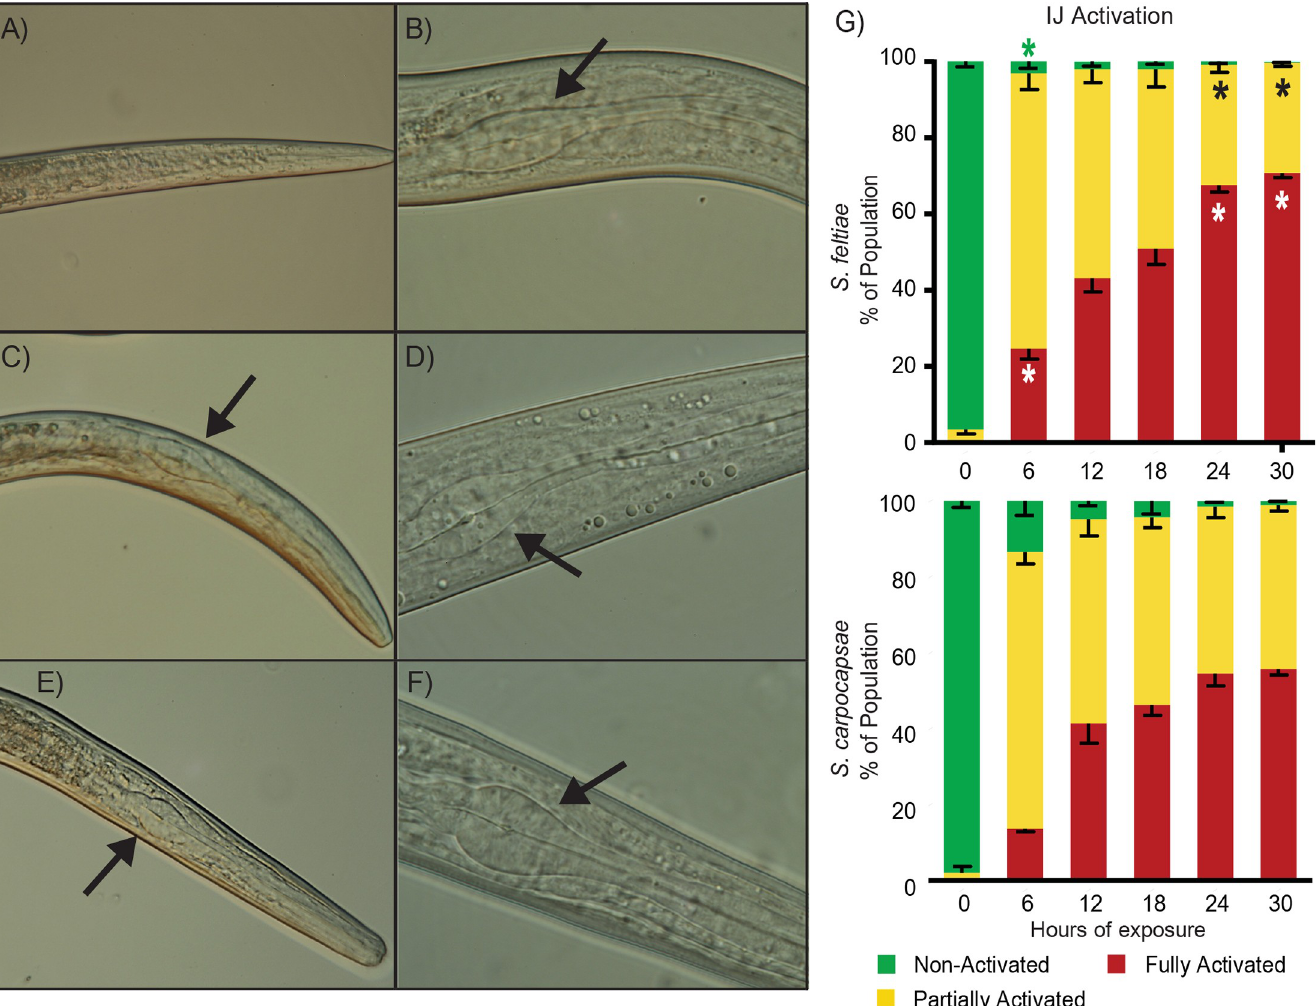
Fig 1. Activation of S . feltiae IJs. The left panel images are representative images of the head region of S . feltiae IJs exhibiting (A) na ï ve, (C) partially activated, and (E) fully activated morphology (400x). The pharyngeal bulb, if observable, is indicated by a black arrow. The right panel images are 1000x representative images of the S . feltiae IJs exhibiting activation morphology corresponding to the left panel images with (B) na ï ve, (D) partially activated, and (F) fully activated. (G) Time course activation rates based on activation morphology of IJs exposed to insect homogenate for 0, 6, 12, 18, 24, and 30 hours. All activation rate data was taken from IJs observed under 400x. The top graph is of S . feltiae activation and bottom graph is of S . carpocapsae activation ( S . carpocapsae activation was reproduced from Lu. et al, 2017 with the addition of a 0-hour time point). Stars in the columns of the S . feltiae activation graph indicates a significant difference with p < 0.05 between S . feltiae and S . carpocapsae rates of the same category (e.g. S . feltiae 6 hr full activation compared to S . carpocapsae 6 hr full activation, data in S1 Table). Column bars represent the mean with error bars representing standard deviation. Statistical analysis was done using a repeated measures two-way ANOVA with Sidak’s multiple comparisons test.